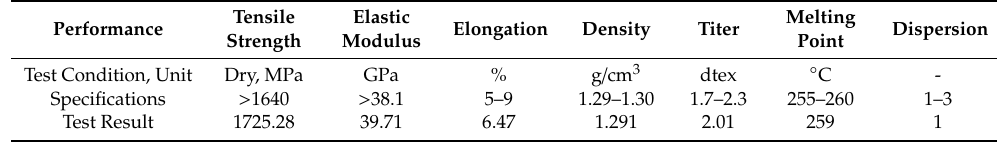
Figure 2. PAN fiber for the test. Table 4. Characteristics of the PAN fiber.